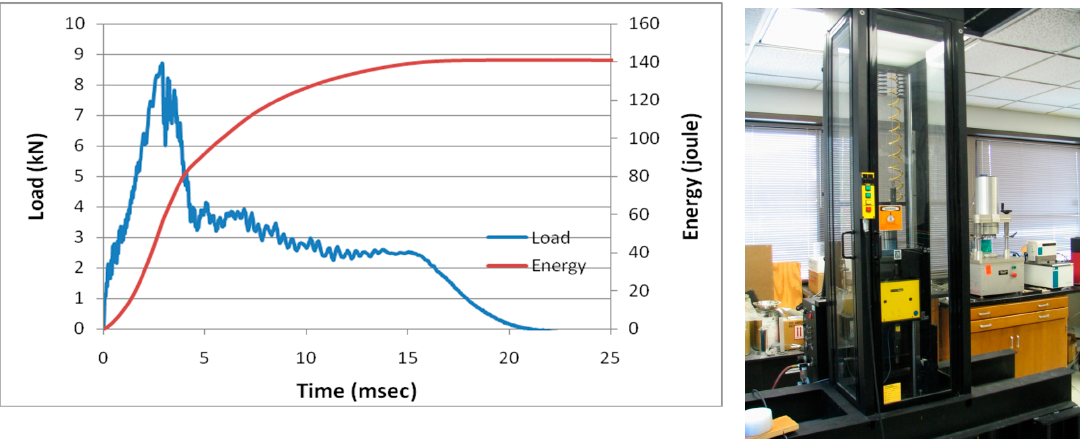
Figure 16. Low velocity impact to composite plates; ( left ) Representative load and energy versus time and ( right ) instrumented drop weight impact setup.